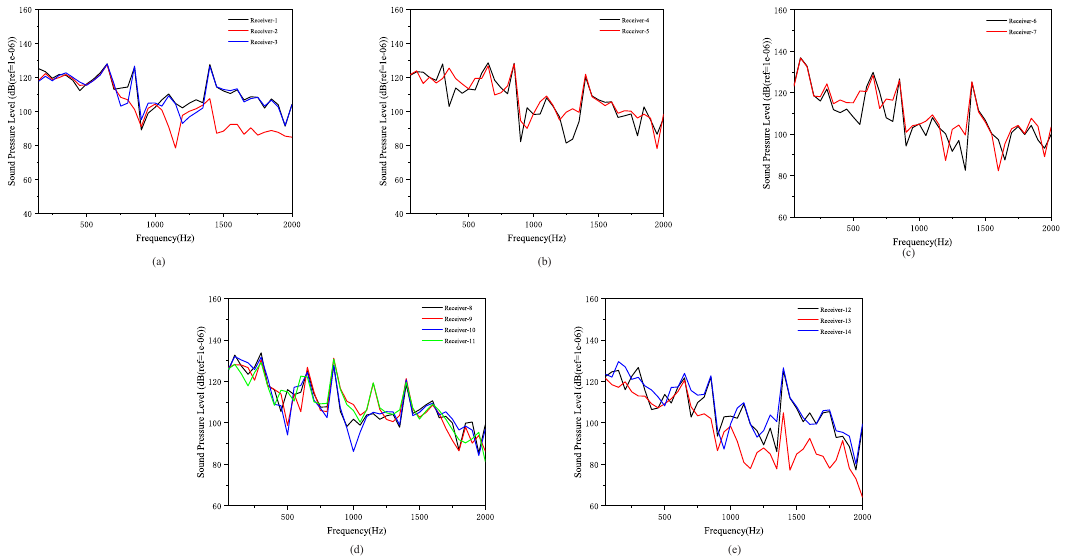
Figure 12. Spectral characteristics of sound pressure at different monitoring points along the flow direction considering vibration excitation. ( a ) Receiver 1–3 ( b ) Receiver 4–6 ( c ) Receiver 6–7 ( d ) Receiver 8–11 ( e ) Receiver